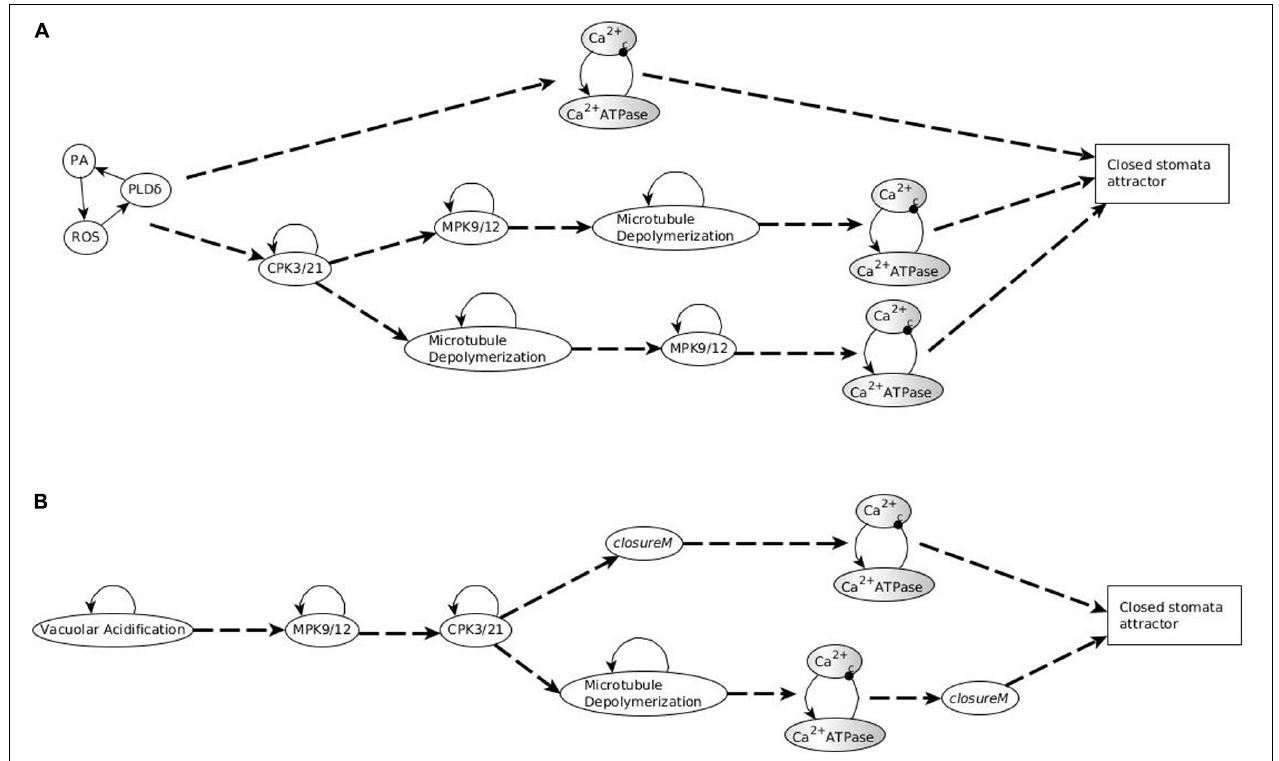
FIGURE 4 | Motif succession diagram of Model1 in the presence of a closure inducing signal. As in Figure 3 , stable motifs are shown with oval symbols and attractors are indicated by rectangles. Each dashed directed line between two motifs indicates that the system states in which the first motif has established and any nodes driven by it have stabilized admit the second motif as next to activate. The dashed directed line converging into an attractor symbol indicates that the succession of stable motifs ensures the system’s convergence into the respective attractor. White background indicates the ON state of the corresponding node and white-gray background indicates oscillating nodes. (A) Motif succession diagram in the sustained presence of ABA when the first motif to stabilize is the PA = 1, PLD δ = 1, ROS = 1 stable motif. The top trajectory is the case when the oscillatory motif stabilizes into oscillations after the PA-PLD δ -ROS motif stabilizes; as a result of the Ca 2 + c – Ca 2 + ATPase oscillations, the motifs CPK3/21 = 1, MPK9/12 = 1, and Microtubule Depolymerization = 1 stabilize directly and hence the system stabilizes in the closed stomata attractor. The middle and bottom trajectories represent the case when the second motif to stabilize is CPK3/21 = 1. The complete succession diagram covers all possible trajectories that start with stabilization of one or more of the four stable motifs (in any order), followed by the activation of the oscillatory motif, after which the system always stabilizes into the closed stomata attractor. (B) Motif succession diagram when external Ca 2 + is simulated as the fixed ON state of the CaIM node when the first three motifs to stabilize are Vacuolar Acidification = ON, MPK9/12 = ON, and CPK3/21 =